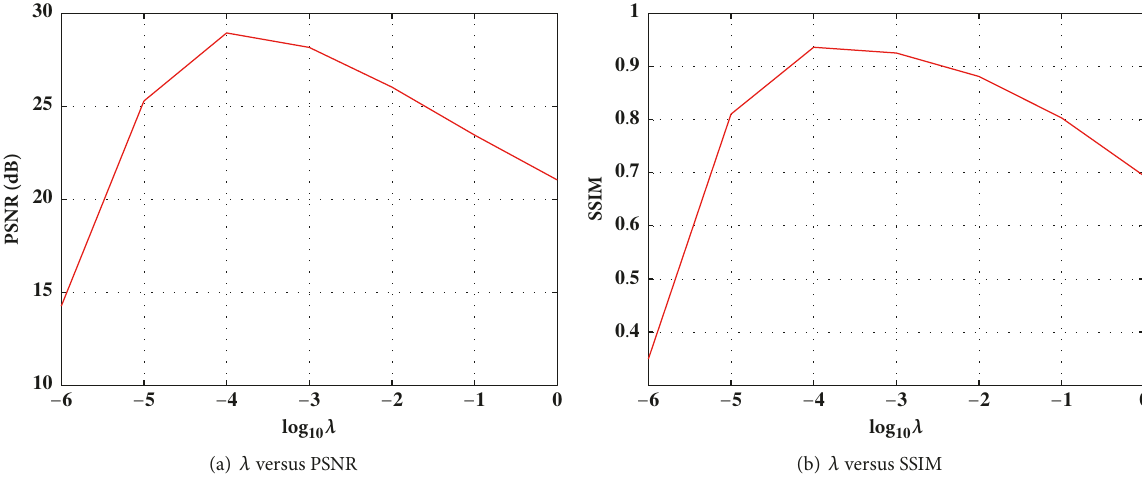
Figure 4: Penalty parameter 𝜆